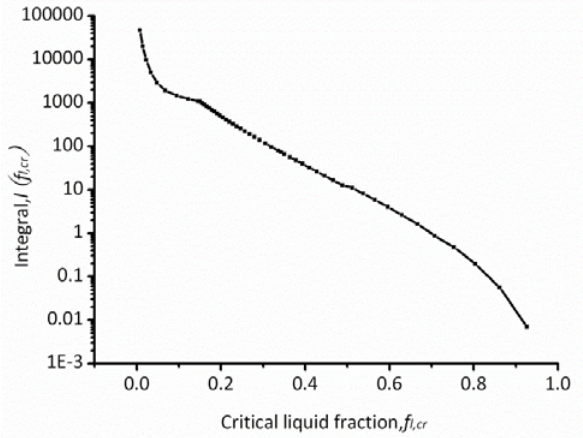
Figure 8. Variation in the integral with critical liquid